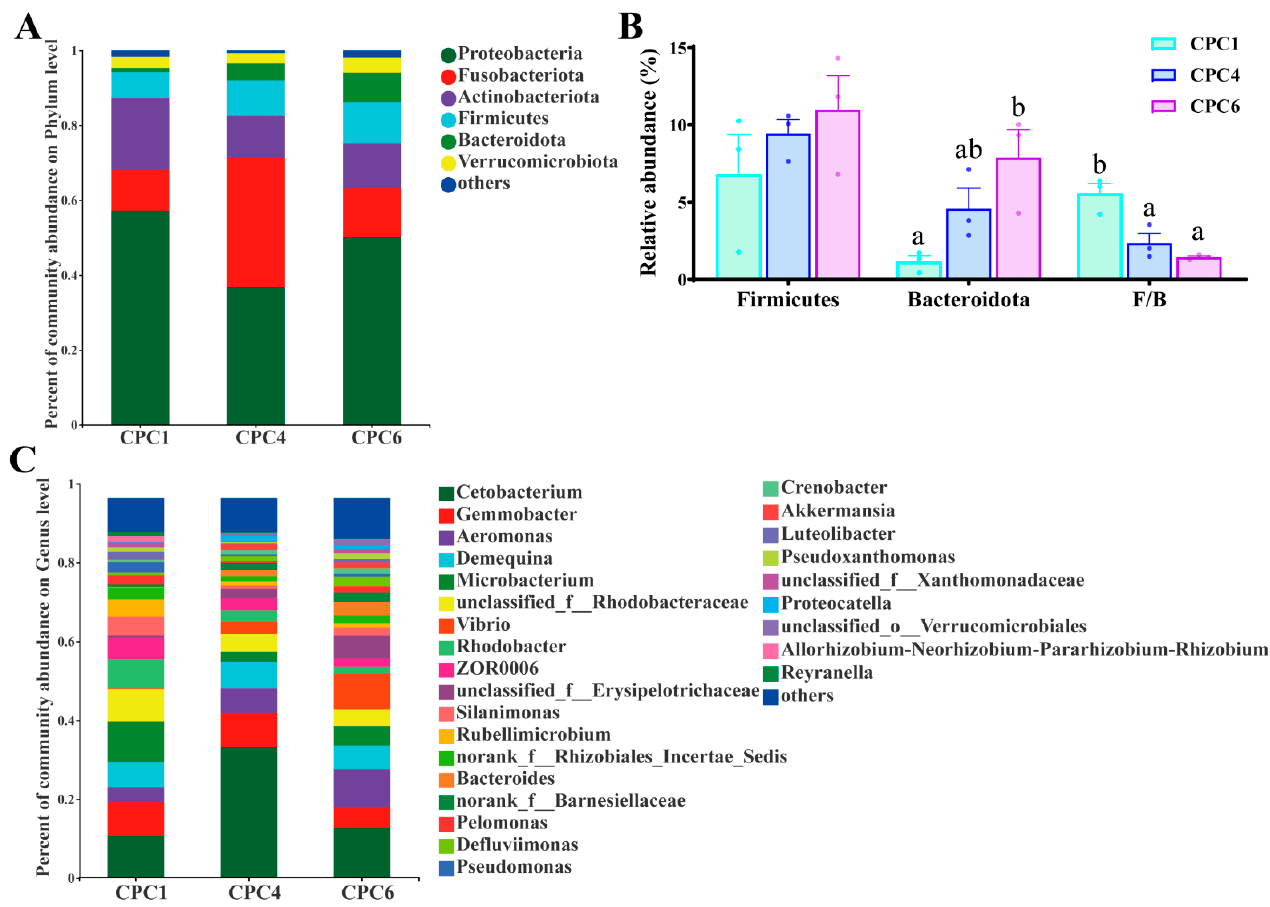
Figure 9. Community composition of intestinal microbiota from different dietary protein treatments. After being fed for eight weeks: the abundance of the intestinal microbial composition at the phylum ( A ) and genus ( C ) level of grass carp in the different protein level groups. Taxa with abundances <1% are included in “Others”. ( B ) One-way ANOVA significance tests were performed for Firmicutes, Bacteroides, and F/B (ratio of Firmicutes to Bacteroides). All data are the means of three parallel tanks ( n = 3). Mean values with different superscripts were significantly different ( p < 0.05), and the mean values without superscripts were not significantly